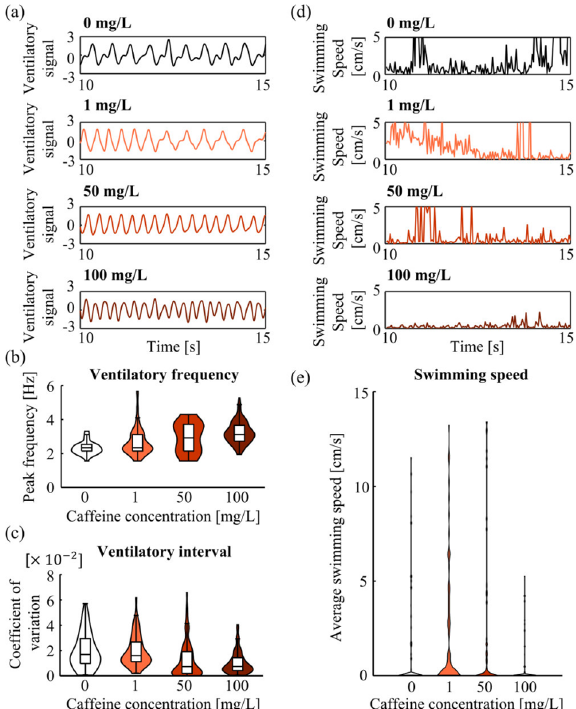
Figure 2. Peak frequencies of ventilatory signals, ventilation variability, and swimming speeds under free- swimming conditions. Data were obtained from five individuals per caffeine concentration. Violin plots include 120 (five individuals, 120 s of measurement duration divided into 5 s segments) data points each. The boxplots in the violin plot present the upper quartile, median, and lower quartile, and whiskers extend from maximum to minimum value, excluding outliers. ( a ) Standardized ventilatory signals. ( b ) Distribution of peak frequencies for ventilatory signals at each caffeine concentration. ( c ) Distribution of coefficients of variation for ventilatory intervals at each caffeine concentration. ( d ) Swimming speed waveform. ( e ) Distribution of average swimming speeds of each 5 s interval at each caffeine concentration.